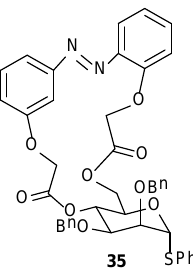
Figure 23. Mannose derived macrocyclic azobenzene.